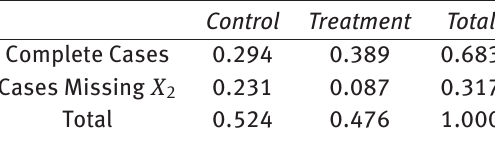
Table 1: Average Missingness vs Treatment Assignment